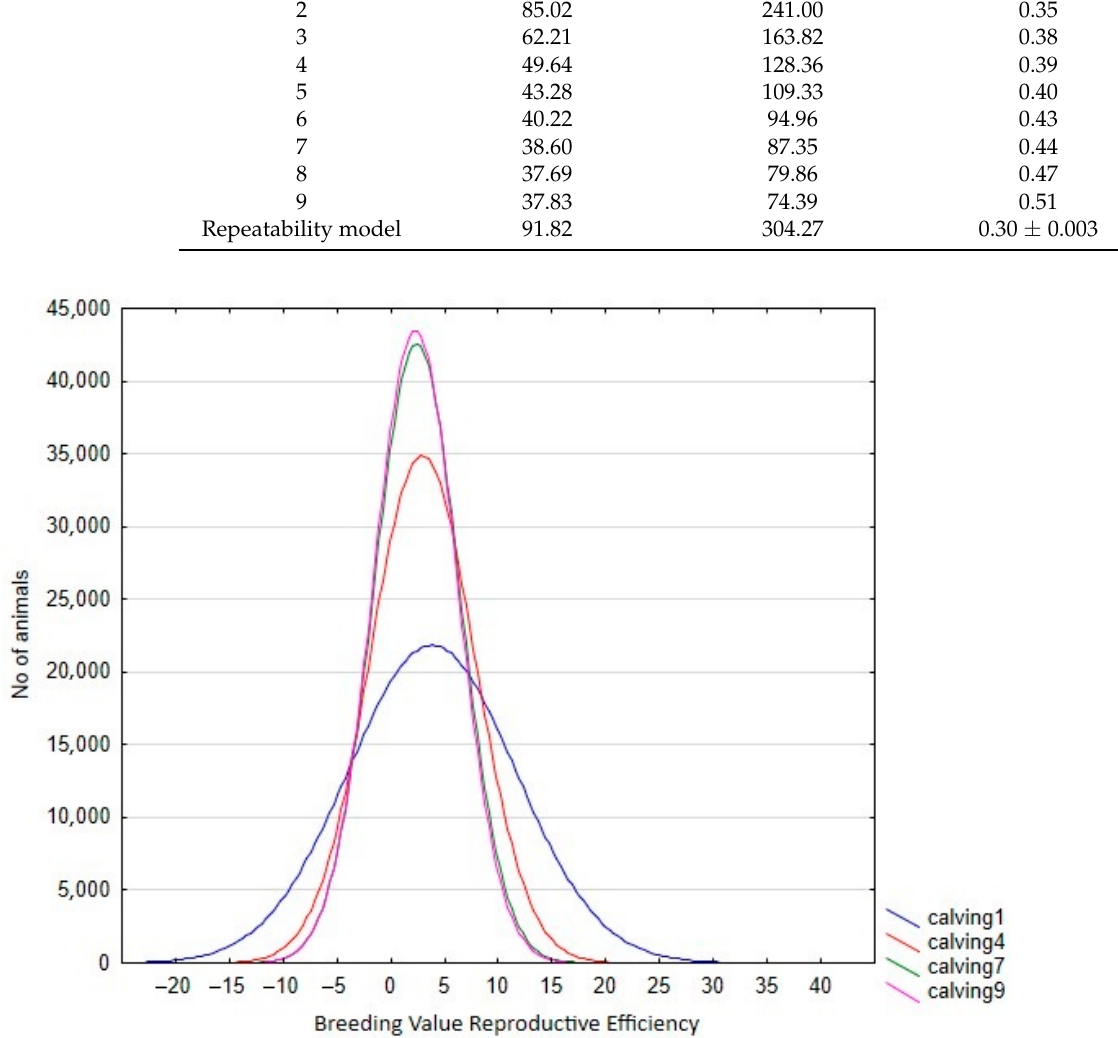
Figure 3. Variation in breeding value for reproductive efficiency per calving in the Retinta breed, estimated by random regression models.